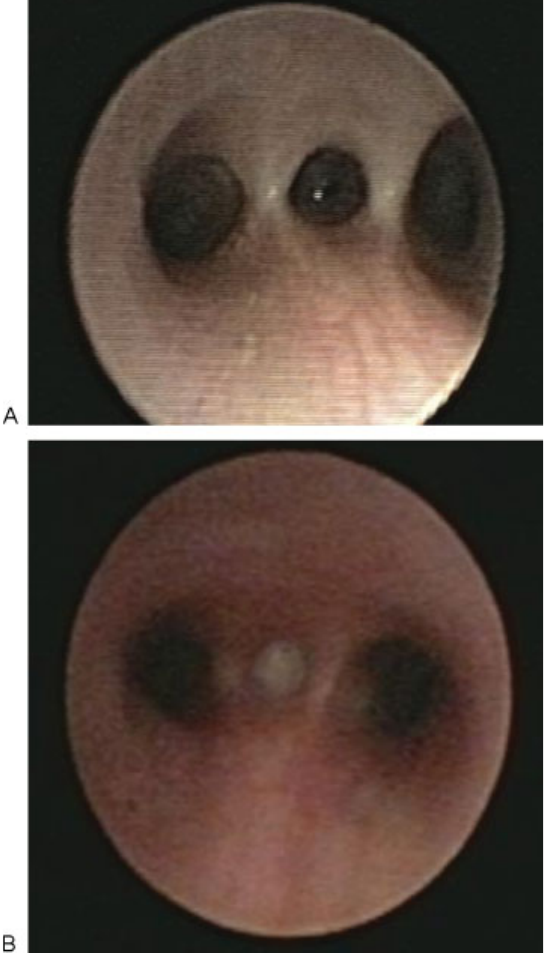
Fig. 2 Image A was taken at initial bronchoscopy con fi rming the diagnosis of ectopic tracheal bronchus that entered between the two main stem bronchi. Image B was taken following recovery from pneumonia showing persistent pus containing Haemophilus in fl uenzae.